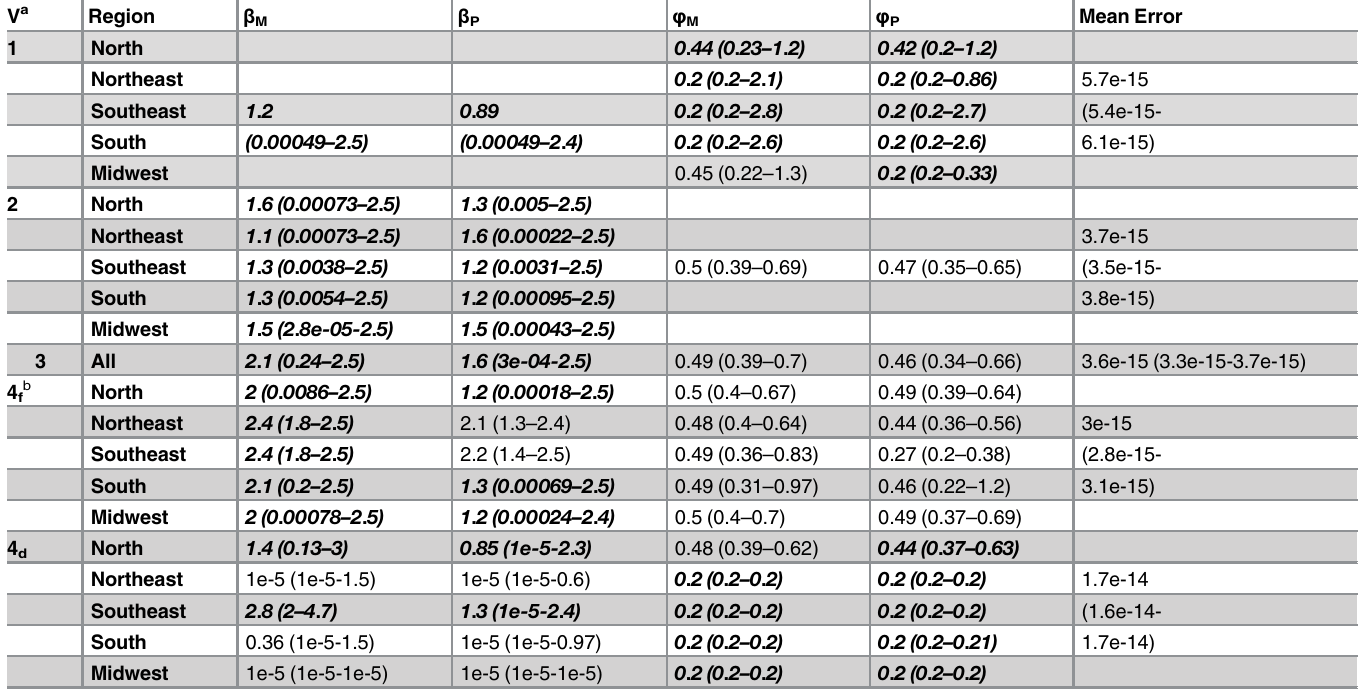
Table 4. Posterior distribution median and 95% prediction intervals determined by ABC fitting of Approximate Bayesian Computation models for Hansen ’ s Disease to data simulated by the best-fit model. The values fit were β M = 1.9, β P = 1.2, φ M = 0.2, and φ P = 0.2 for all but the North, where φ 2 = 0.46. Version 4 consisted of fitting the regional best-fit model to each region ’ s observed data separately with both frequency and density-dependent transmis- sion assumptions; all other versions used a hierarchical structure with density-dependent transmission in which at least some parameters were shared across regions, and fitting was done simultaneously across all 5 regions. Values in bold italics contained the simulated value within their range. Mean error refers to the average value of d per iteration of each version, based on a sample of 1,000 iterations, with confidence intervals based on 100 samples of 100 iterations each.